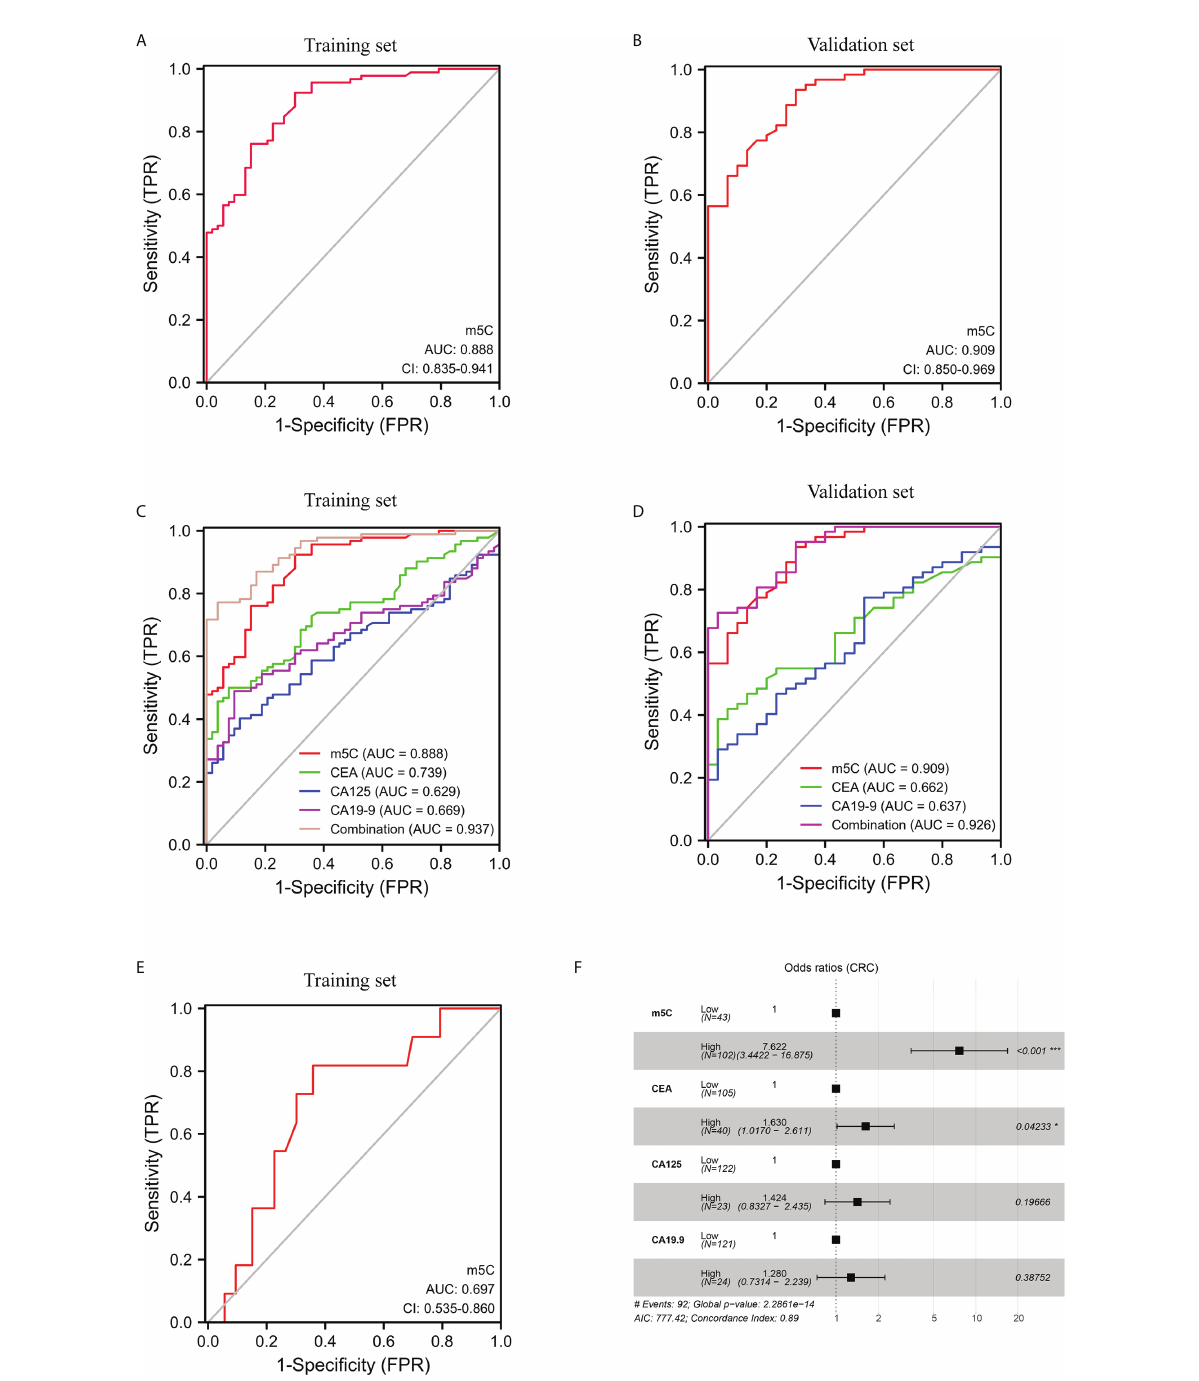
FIGURE 2 Clinical utility of m 5 C modi fi cation in peripheral blood immune cells for the diagnosis of CRC. (A, B) ROC curve for m 5 C modi fi cation of peripheral blood immune cells in the training set (A) and validation set (B) . (C, D) ROC curve for m 5 C modi fi cation compared with CEA, CA19-9, and CA125 in the training set (C) and validation set (D) . (E) ROC curve for m 5 C modi fi cation of early-stage CRC in the training set. (F) Forest plot of multivariate logistic regression indicated predictive factors for CRC diagnosis in the training